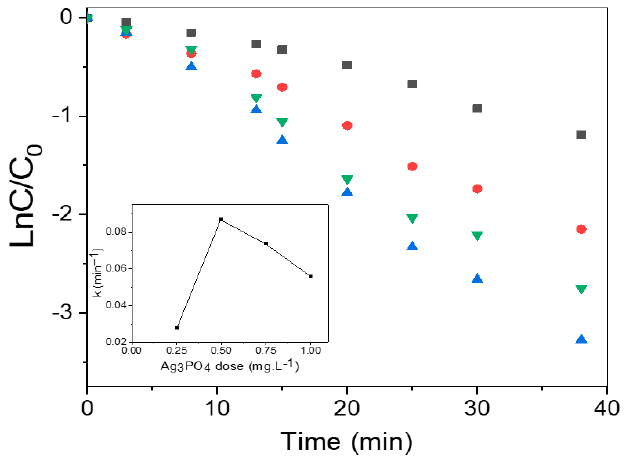
Figure 9. Effect of the catalyst dose Ag 3 PO 4 on its photocatalytic performance, (cid:4) : 0.25 g · L − 1 , (cid:78) : = 0.5 g · L − 1 , (cid:72) : 0.75 g · L − 1 , • : 1 g · L − 1 . Insert: Rate Constants vs. Ag